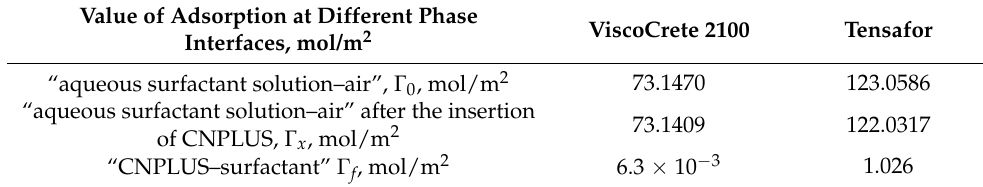
Table 6. Specific adsorption activity of surfactants’